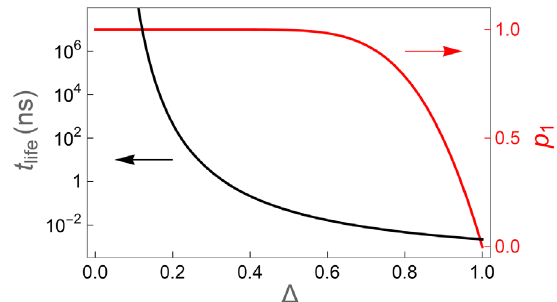
FIG. 7. The volume fraction p 1 (red curve) of SC domains and the lifetime t (black curve) of the metastable state as a function life = γ 1 α 1 of Δ ¼ γ 2 α 2 predicted by Eqs. (27) and (28). The L L Ginzburg parameter is ζ ¼ 10 − 2